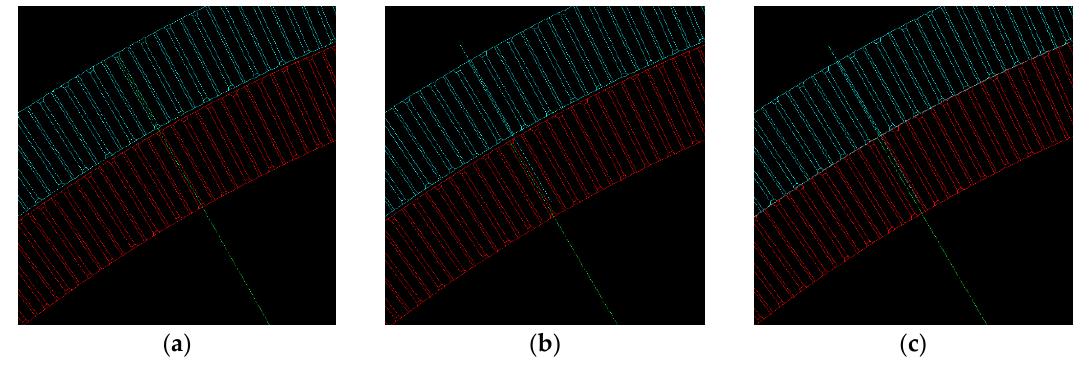
Figure 8. ( a ) Ring #1 and ring #2 engaged correctly; ( b ) before engagement: pure angular misalignment; ( c ) before engagement: center misalignment (which also generates angular misalignment).